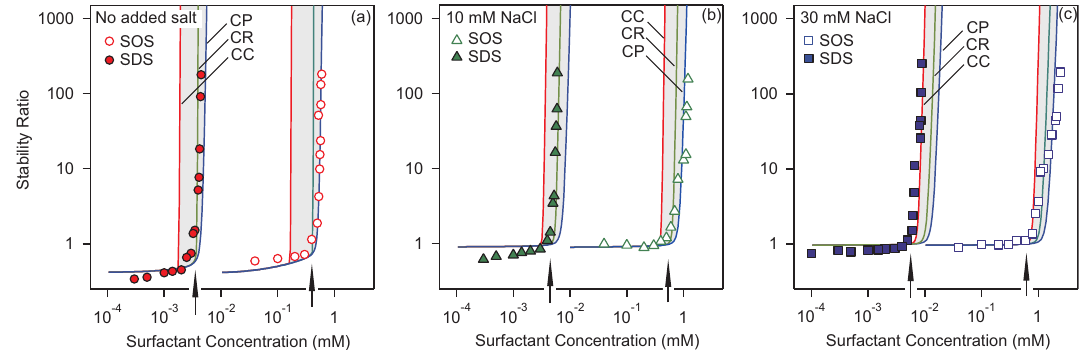
Figure 6. Stability ratios for heteroaggregation of AL and SL particles in the presence of SOS and SDS with ( a ) no added NaCl, ( b ) 10 mM NaCl, and ( c ) 30 mM NaCl added. Symbols represent experimental data, while lines show calculations based on DLVO theory. CC, CR, and CP labels mark constant charge, constant regulation, and constant potential boundary conditions. For the CR model the regulation parameters for both particles are equal to 0.5. The IEPs are indicated with